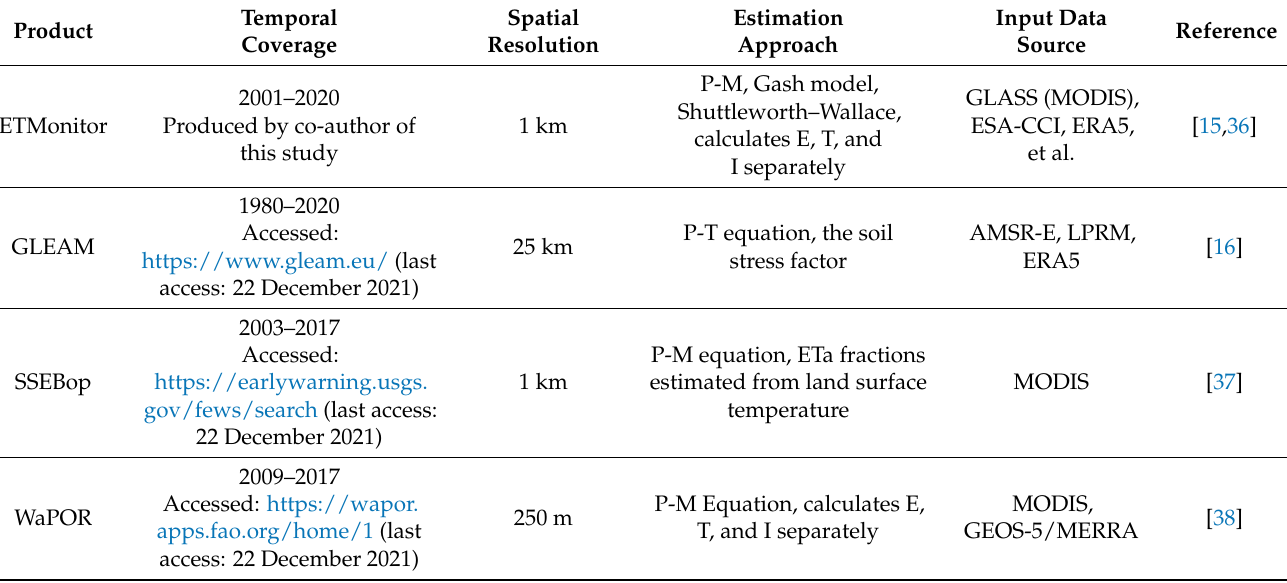
Table 3. Satellite-observation-based actual evapotranspiration products used for calibration of the SWAT model (E: soil evaporation; T: transpiration; I: rainfall